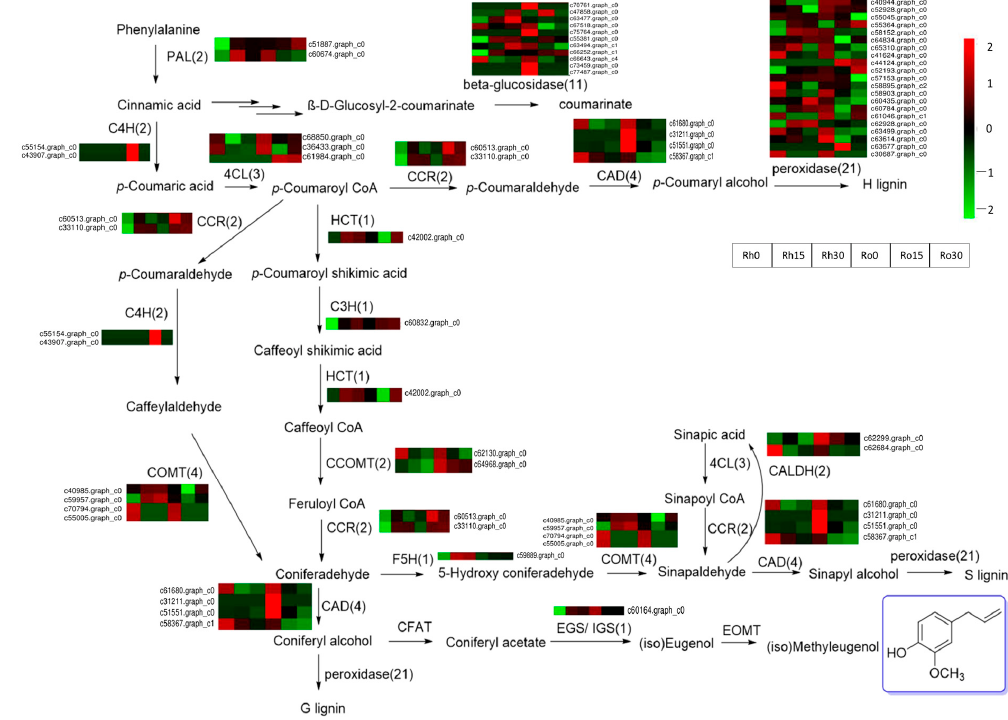
Figure 6. Changes in the expression level of the methyleugenol biosynthesis related genes. 57 DEGs were used for the heatmap, and the color indicates the FPKM value (log10) of the unigenes encoding the corresponding enzyme. The six colored boxes from left to right represent the gene expression value in Rh-0, Rh-15, Rh-30, Ro-0, Ro-15, and Ro-30. Numbers of putative unigenes were given in parentheses.